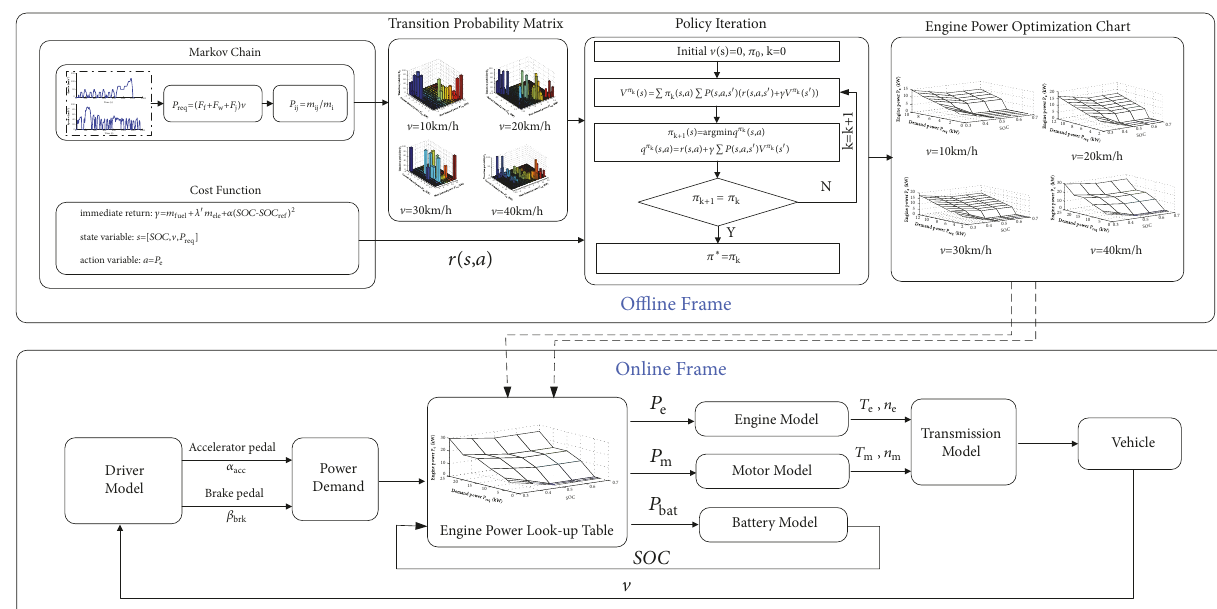
Figure 10: Implementation frame of the energy management